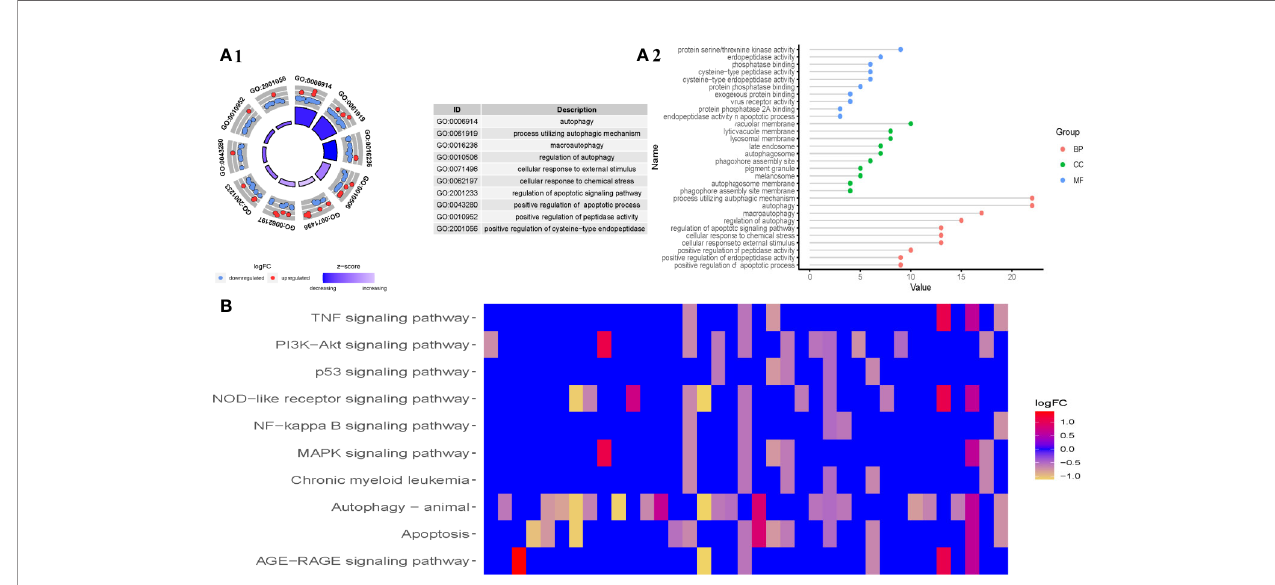
FIGURE 2 | Gene functional enrichment analysis of differentially expressed ARGs in MDS. (A1) The top 10 results of the GO enrichment analysis of differentially expressed ARGs, and (A2) the top 10 for each category (biological processes, molecular functions, and cellular components). (B) Top 10 of KEGG pathway analysis of differentially expressed